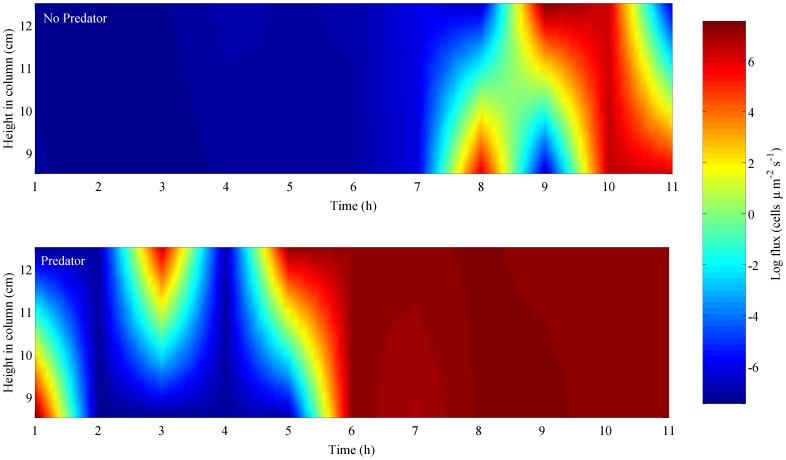
Below halocline vertical flux.Vertical flux (log cells µm−2 sec−1) of H. akashiwo, below the halocline, in the absence (top) and presence (bottom) of the predator. Warmer colors = upward flux and cooler colors = downward flux of phytoplankton cells. After 6 h, in the presence of the predator, the vertical flux of H. akashiwo was strongly and persistently upward. In contrast, the vertical flux of H. akashiwo in the absence of a predator was initially downward and then directionally inconsistent resulting in no effective change in population distribution.